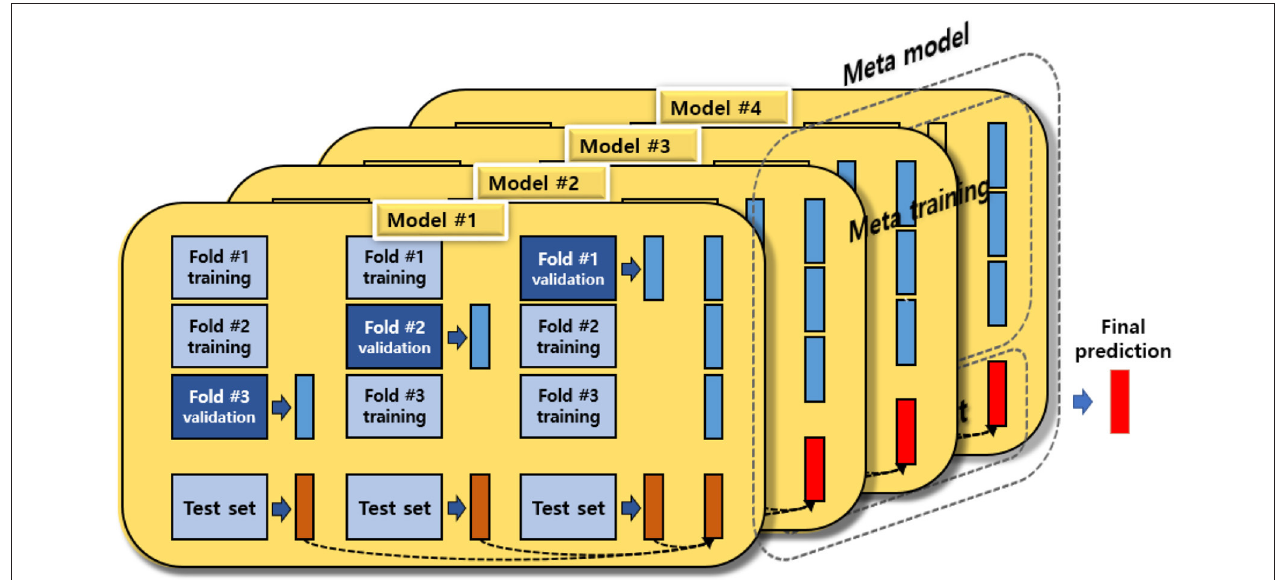
FIGURE 1 | The concept of a stacking